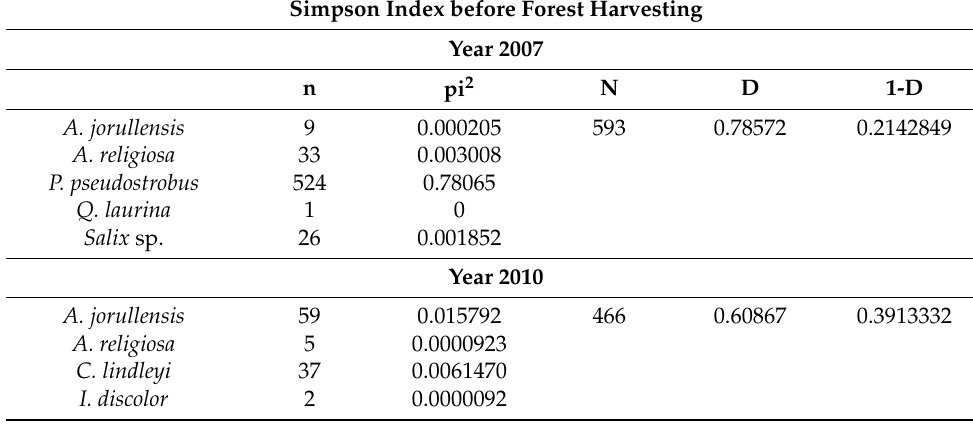
Table 2. Simpson index of diversity before forest harvesting: n = tree density; pi 2 = square of propor- tional abundance; N = overall tree abundance; D = Simpson’s D; 1-D = Simpson diversity